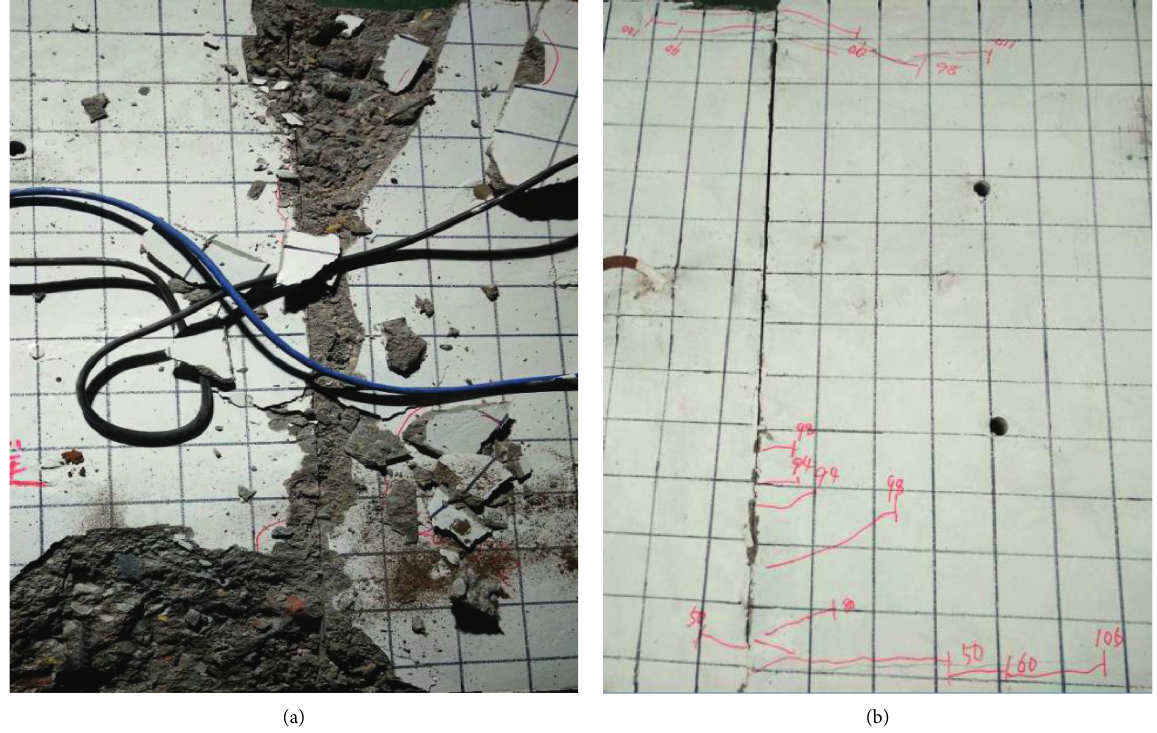
Figure 12: Cracks on top flanges of specimens 1 and 5 after the tests (plan view); (a) specimen 1; (b) specimen